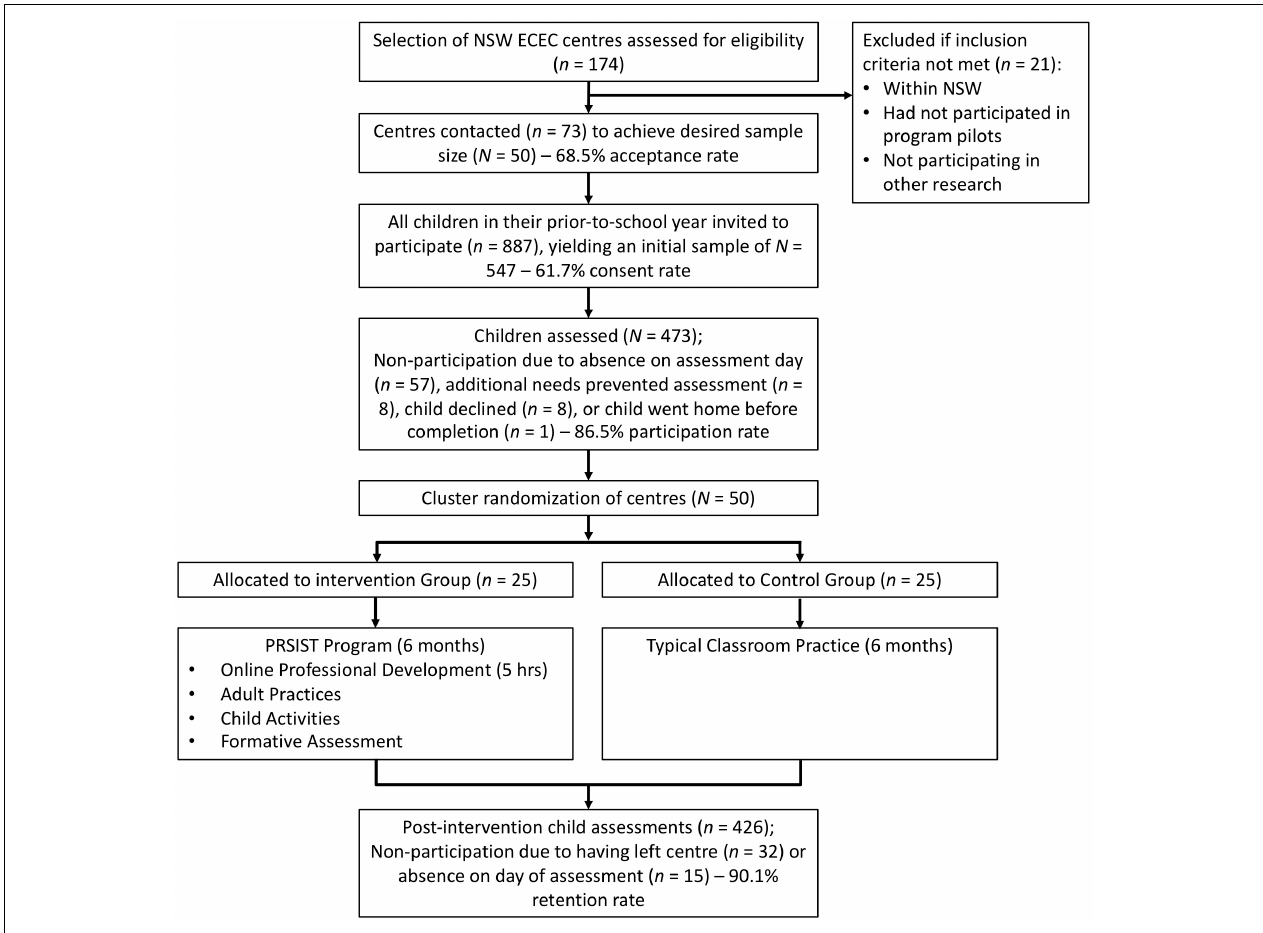
FIGURE 2 | CONSORT flowchart of stages and participants in the